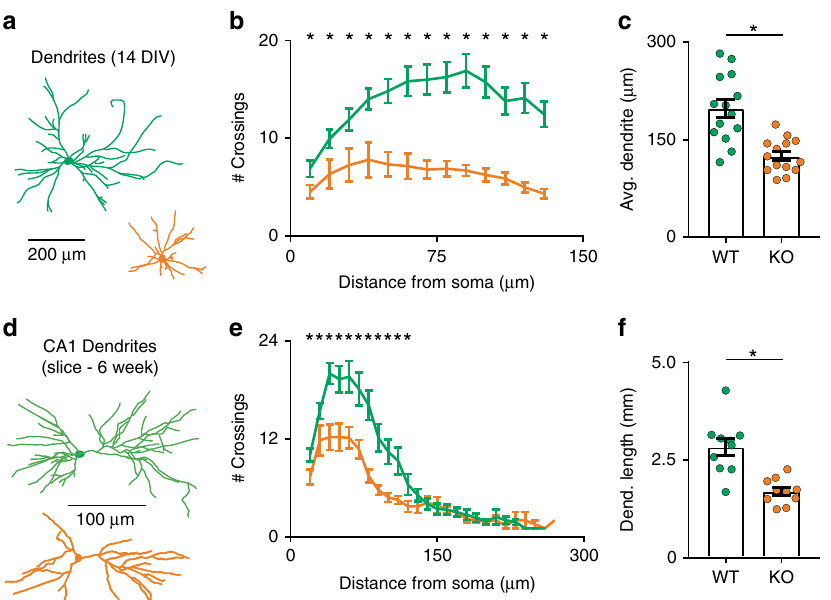
Fig. 4 Stunted dendritic morphology in syt-17 KO neurons in vitro and in vivo. a Neuron morphology at 14 DIV was visualized with sparse transfection of GFP, and dendritic arbors were semi-manually reconstructed based on the presence of dendritic spines and positive MAP-2 immunostaining. b Sholl analysis demonstrating less dendritic branching complexity in neurons lacking syt-17. c The average primary dendrite length was signi fi cantly shorter in syt- 17 KO neurons ( t 26 = 4.731, p < 0.001, r 2 = 0.463, mean wt = 197.86 ± 13.8 μ m, mean ko = 124.8 ± 6.93, N wt = 14 and N ko = 14 neurons). d Dendritic morphology of hippocampal CA1 pyramidal neurons was assessed with Golgi staining, and dendritic arbors from resultant slices were semi-manually reconstructed (two dimensional projections of three dimensional reconstructions are shown). e Sholl analysis indicated less complex dendritic branching in neurons lacking syt-17 in vivo. f Total dendritic length was signi fi cantly reduced in neurons lacking syt-17 ( t 18 = 4.653, p < 0.001, r 2 = 0.382, mean wt = 2.83 ± 0.22 mm, mean ko = 1.7 ± 0.1, N wt = 10 and N ko = 10 neurons). Experiments were performed on 3 – 4 independent preparations of animals. All error bars indicate